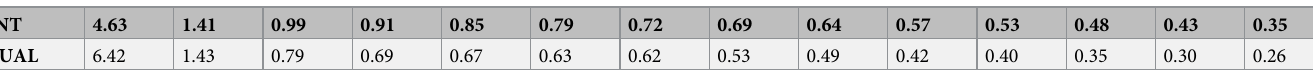
Table 4. Eigenvalues for each factor extracted from LNT sample and GEN